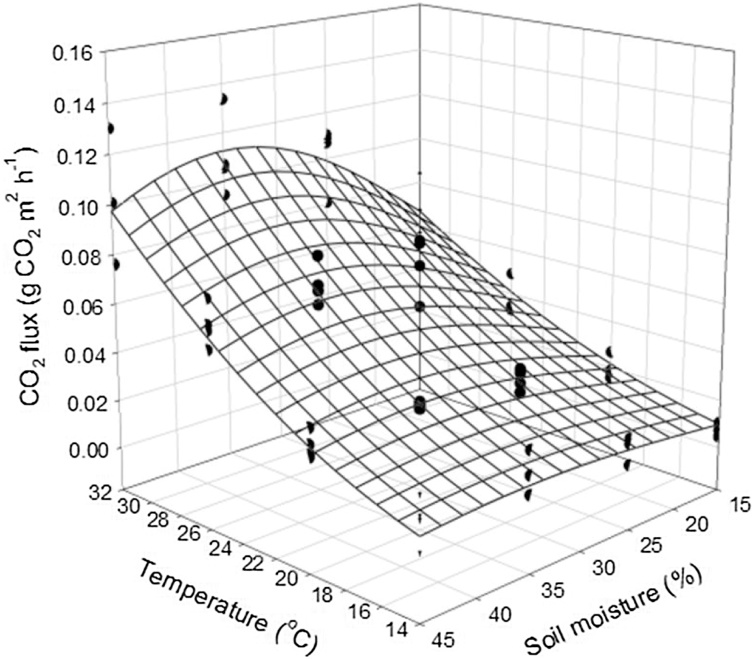
Relationships between temperature, moisture, and CO2 efflux determined from lab incubation data.